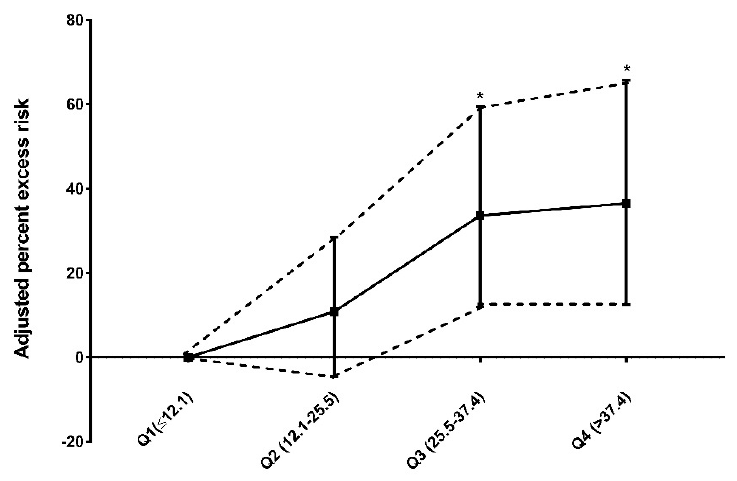
Figure 3. Adjusted risk of stroke according to ambient PM 2.5 levels. The y-axis represents the per- centage of excess risk with 95% confidence intervals. * p < 0.01. percentage of excess risk with 95% confidence intervals. * p <